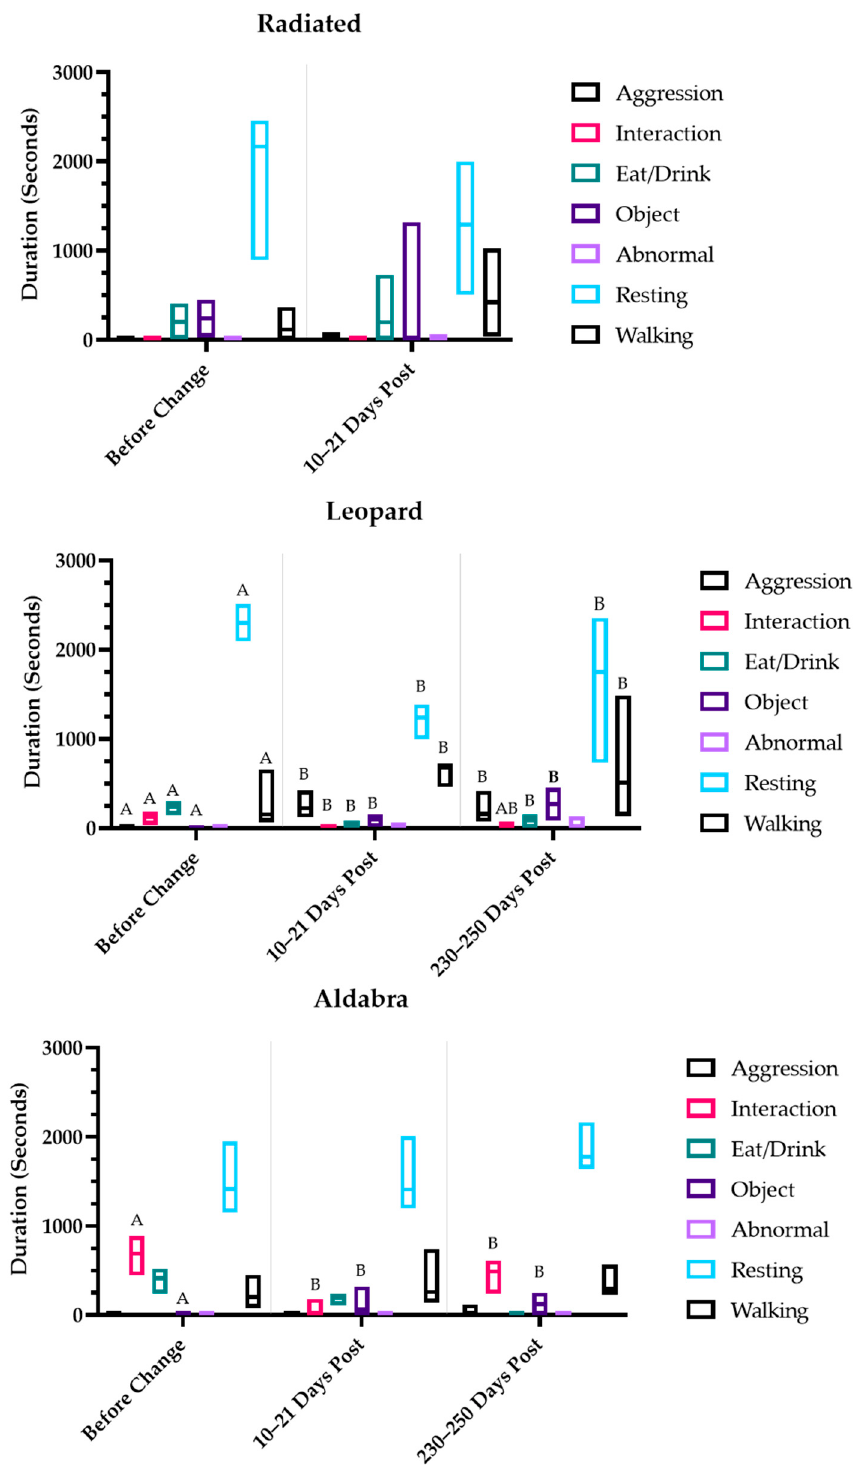
Figure 4. Box Plot of Behaviours Separated by Species at Three Time points: (1) Before Environmental Change, (2) 10–21 days Post Change, (3) 6 months Post Change. ‘Interaction’ refers to ‘co-occupant interaction’ and ‘object’ refers to ‘object interaction’. Pairwise comparisons are indicated with a letter i.e., the letter ‘A’ over two timepoints indicates no difference between those time points for the same behaviour. Different letters indicate a difference between time points. Due to additional husbandry changes subsequent to the second time point, there is no third time point for radiated tortoises.